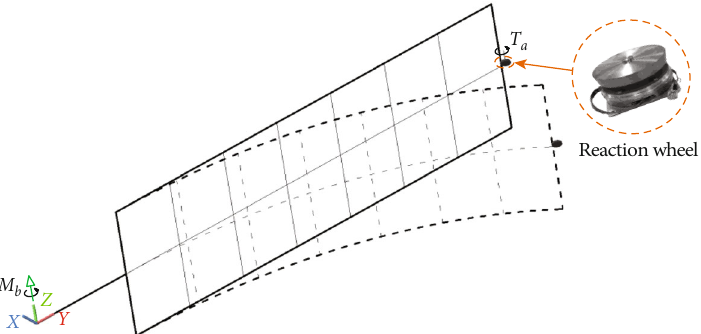
Figure 1: Structural diagram of the solar array with a RW